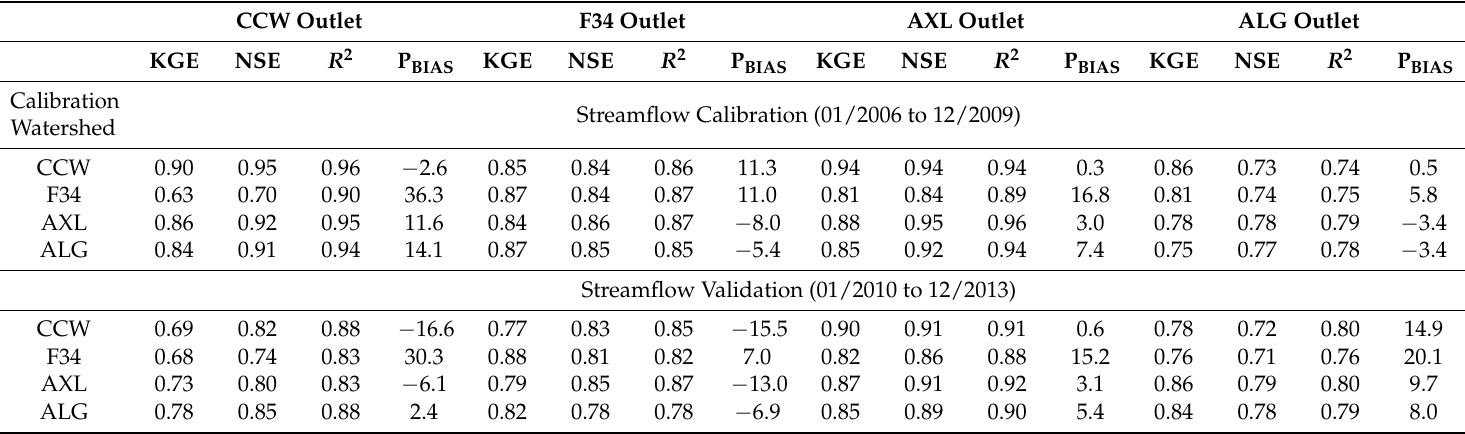
Table 8. Streamflow calibration and validation statistical metrics for CCW, F34, AXL, and ALG SWAT model performance.